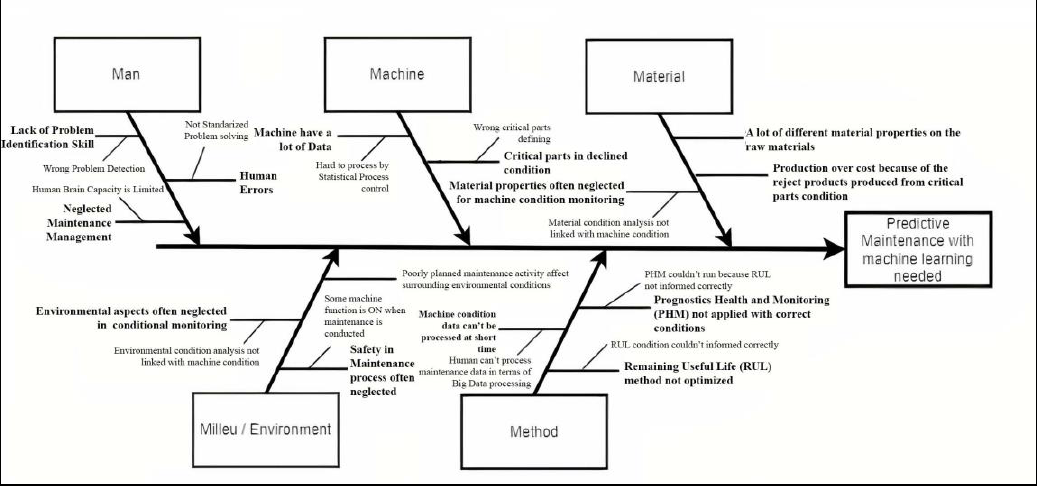
Figure 2. Fishbone diagrams for the research background [27 – 30].